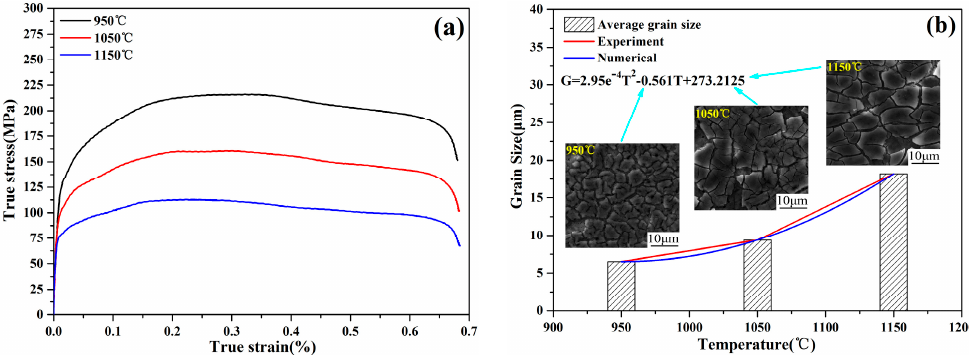
Figure 2. Stress–strain curves ( a ) and grain size data ( b ) of compressed 0.4C-Si-Mn-Cr steel under temperatures from 950 to 1150 °C .